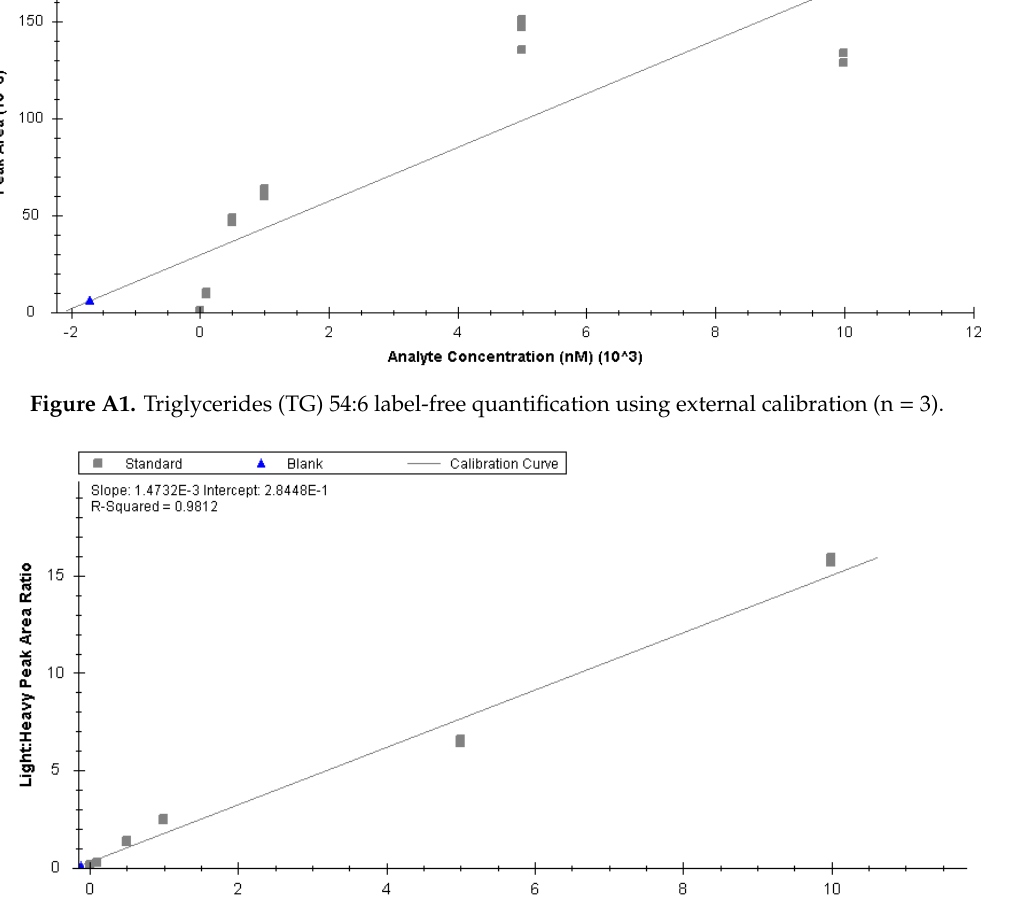
Figure A2. Compound-specific quantification of TG 54:6 using external calibration and internal